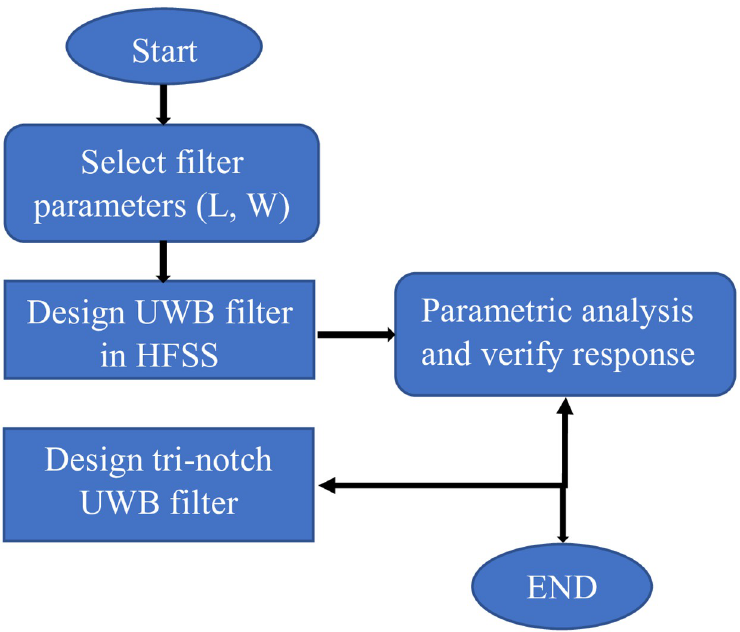
Fig 4. Flow chart for the design of UWB filter with notch bands.